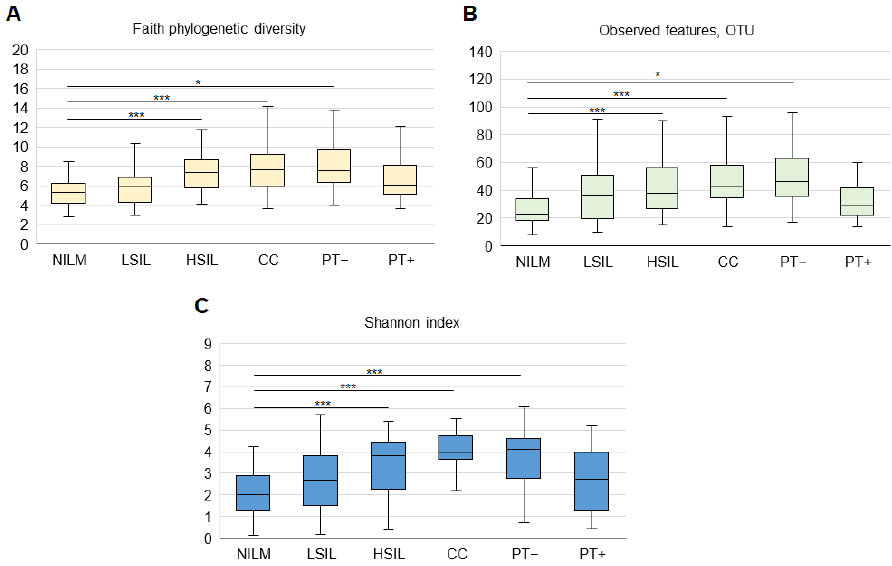
Figure 2. Box–whisker plots for CVM α -diversity parameters at different diagnoses and post-treatment. Box cross-sections, medians; boxes, upper and lower quartiles; whiskers, nonoutlier ranges. Outliers are not shown. PT+, post-treatment, treatment included surgery; PT-, post-treatment, treatment without surgery. ( A ) Faith’s phylogenetic diversity; ( B ) Shannon’s index; ( C ) Operational taxonomic units (OTUs). Differences between groups were assessed by the Mann–Whitney U test with Bonferroni’s correction for multiple testing, and an adjusted p -value was calculated as a pairwise nonadjusted p -value multiplied by the total number of comparisons. *** p ≤ 0.001; * 0.01 < p < 0.05.